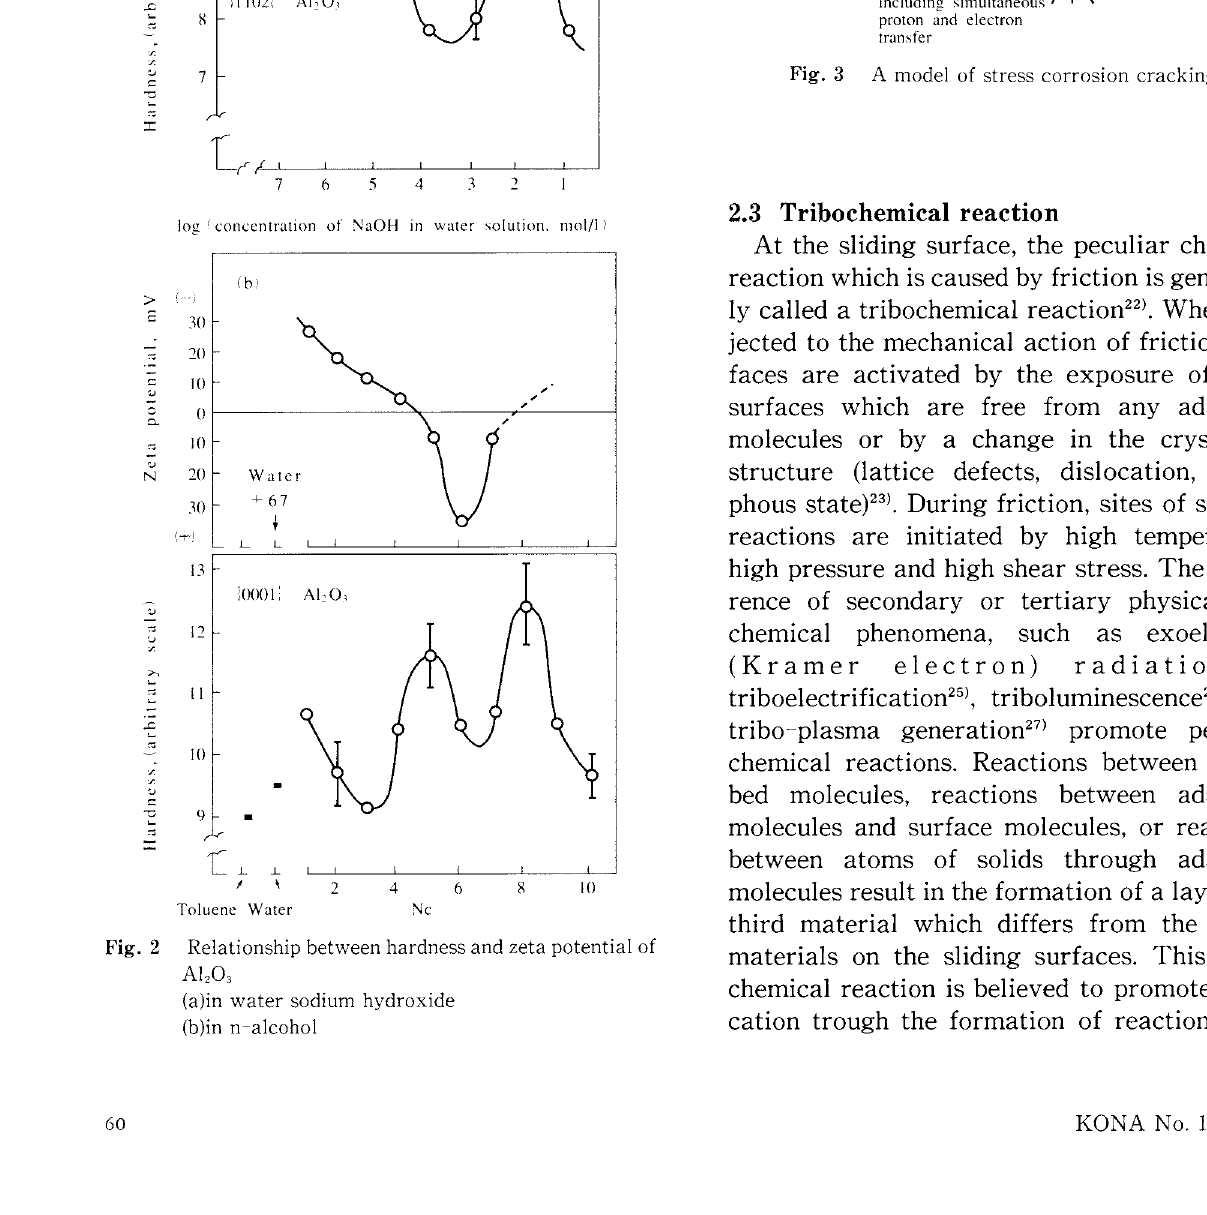
A model of stress corrosion